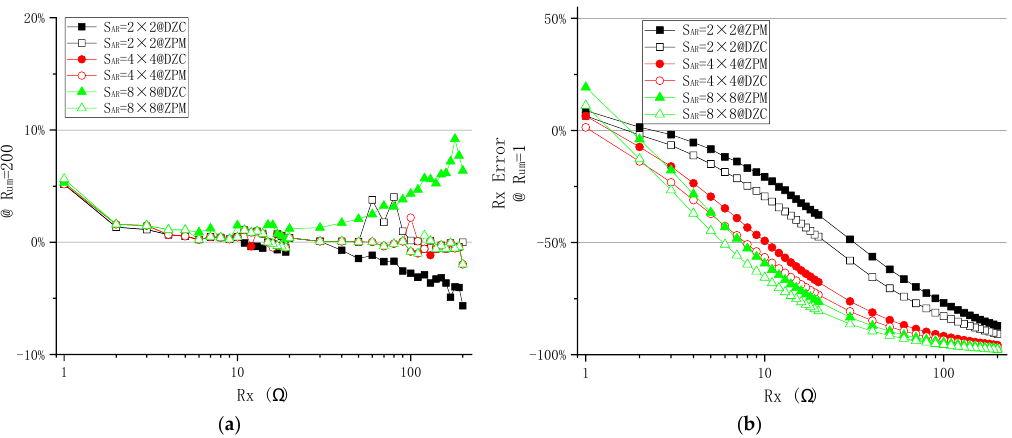
Figure 7. The effect of 𝑅 𝑥 on measurement error of different 𝑆 𝐴𝑅 when ( a ) 𝑅 𝑢𝑚 = 200 Ω and ( b ) Figure 7. The effect of R x on measurement error of different S AR when ( a ) R um = 200 Ω and 𝑅 𝑢𝑚 = 1 Ω in DZCM and ZPM (EXP A). ( b ) R um = 1 Ω in DZCM and ZPM (EXP A).